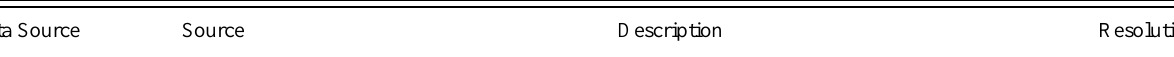
Table 1. GIS datalayers used in the decision support system (DSS). Most datalayers were modified slightly from their original source for this analysis. The source column includes an acronym for the agency providing the data and the year of the datalayer used in our analysis. Data processing notes are included in the description column. Full data references are included in the literature